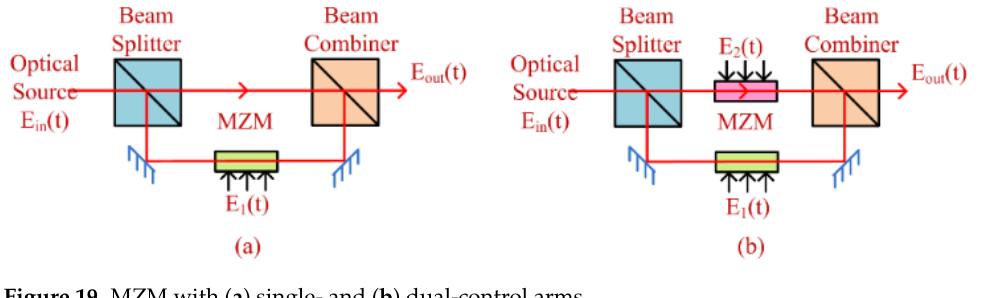
Figure 19. MZM with ( a ) single - and ( b ) dual-control arms:.